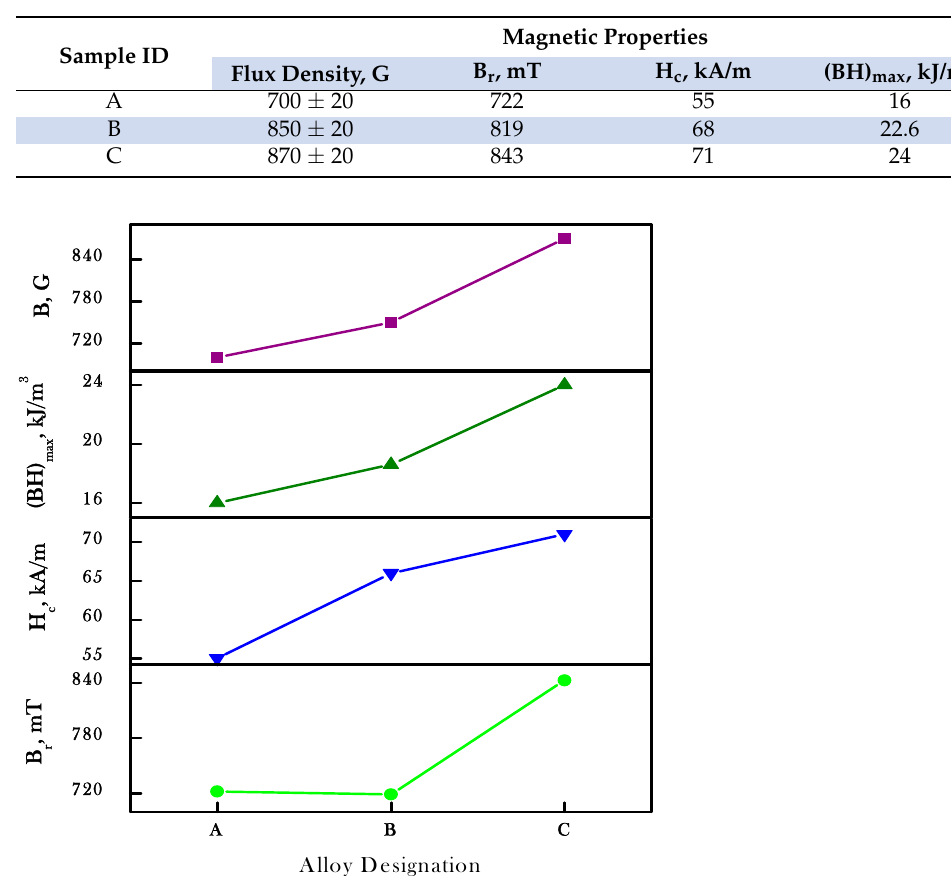
Figure 8. Magnetic properties vs. alloy designation of Sample A, Sample B and Sample C after complete treatments.